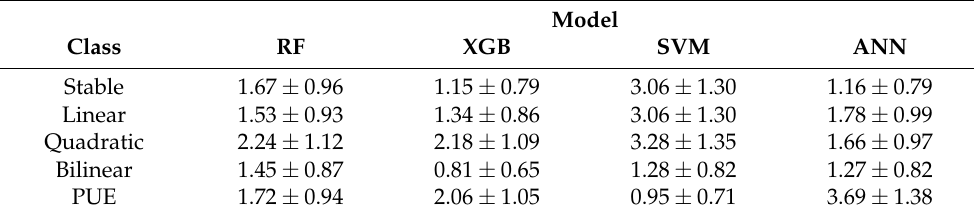
Table 5. FAR values (%) of the four proposed models, integrated by the CIs of a 0.01 level of